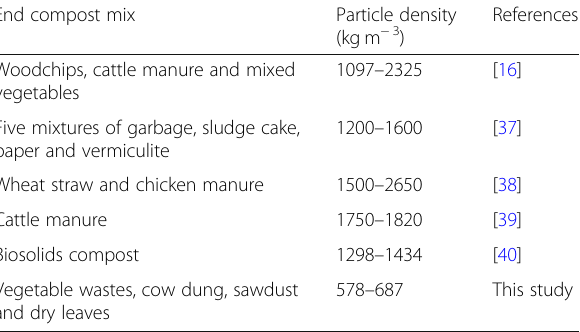
Table 5 Particle density in the different compost mixtures at